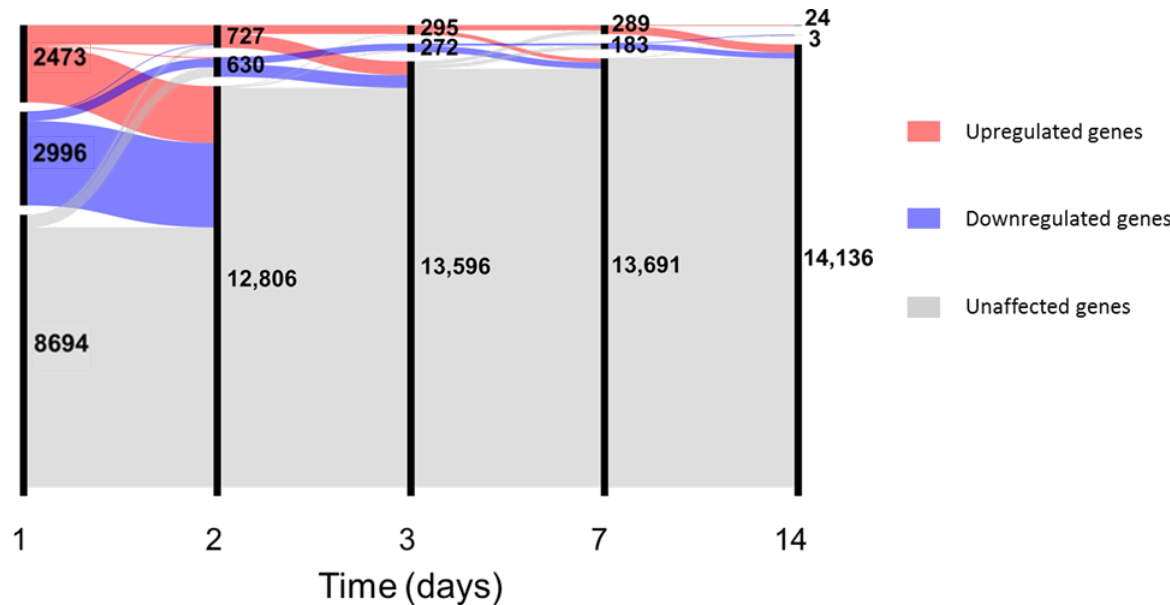
Figure 2. Number of differentially expressed genes up to day 14. In the alluvial plot, each vertical line represents a time point, the line is broken in sections proportional to the number of upregulated (red), downregulated (blue) and unaffected (grey) genes. Changes in composition of the different sections are shown by the lines connecting the time points. Data for plot construction were retrieved from the glmTreat analysis with edgeR. Days 21 and 28 are not shown since no differentially expressed genes (DEGs) were detected.